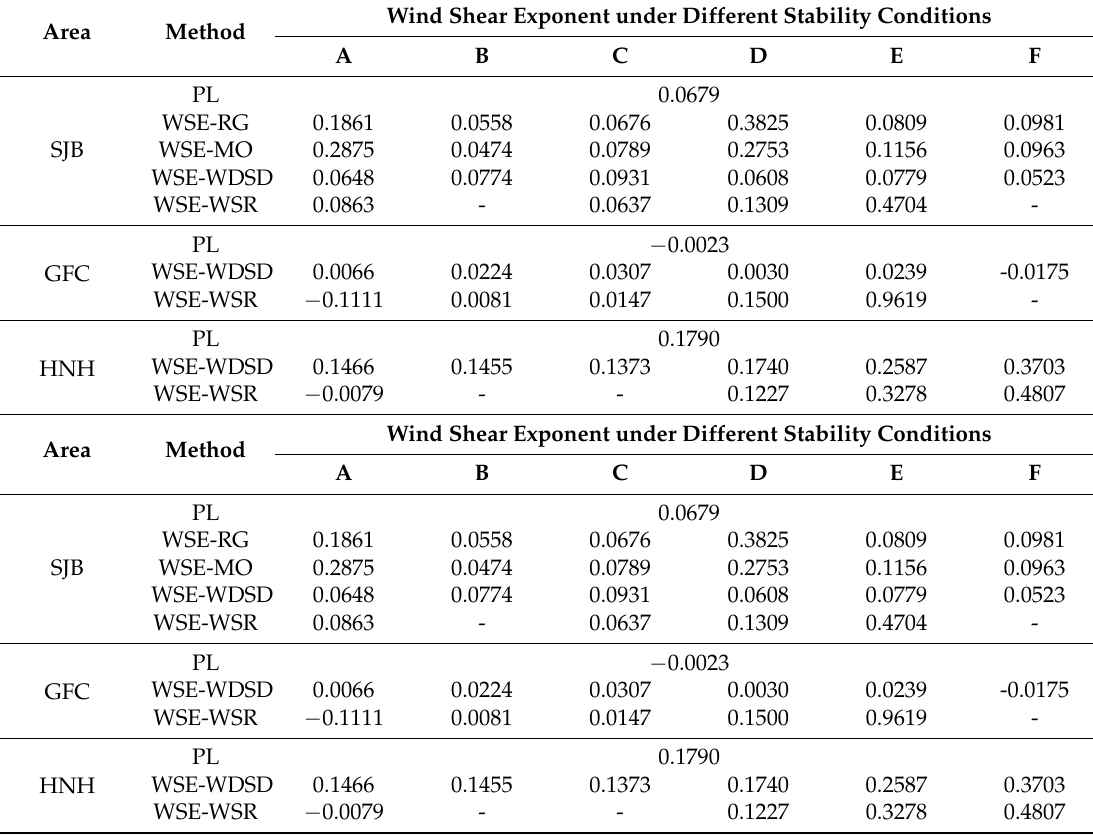
Table 8. Wind shear exponents in different areas.